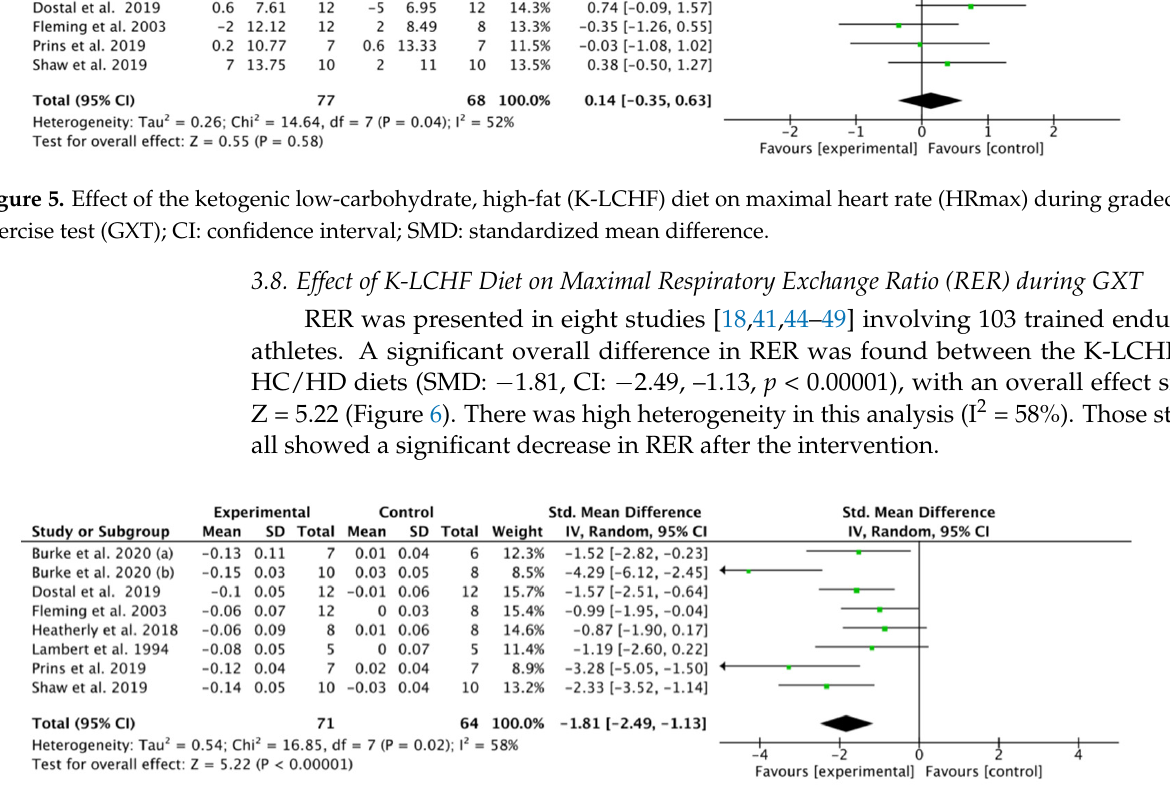
Figure 6. Effect of the ketogenic low-carbohydrate, high-fat (K-LCHF) diet on respiratory exchange ratio (RER) during graded exercise test (GXT); CI: confidence interval; SMD: standardized mean difference.